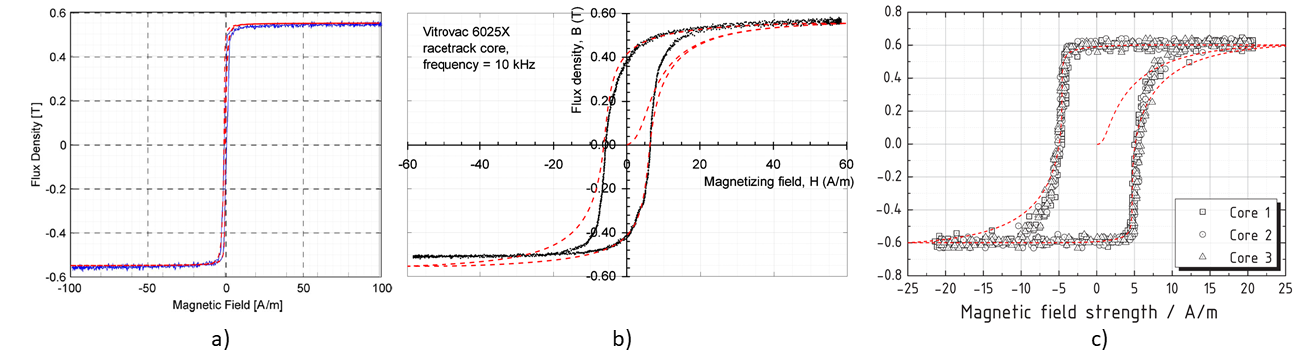
Figure 5. Fitted hysteresis loops (dashed red lines) overlapped to the original images for the cases named JA1, JA2, and JA3, respectively, in ( a – c